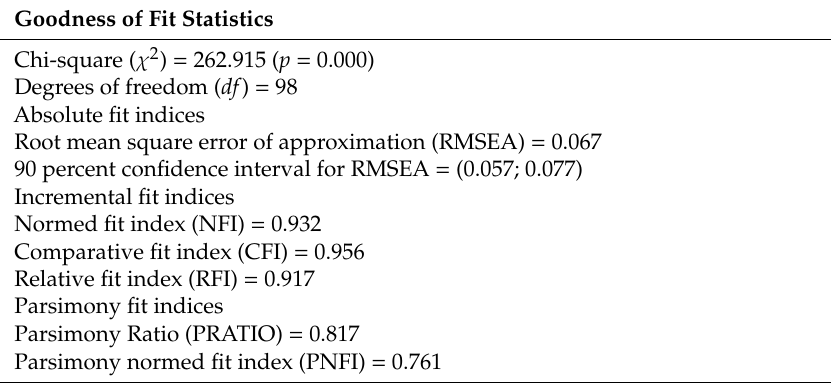
Table 3. Summary of the adjustment indices of the measurement